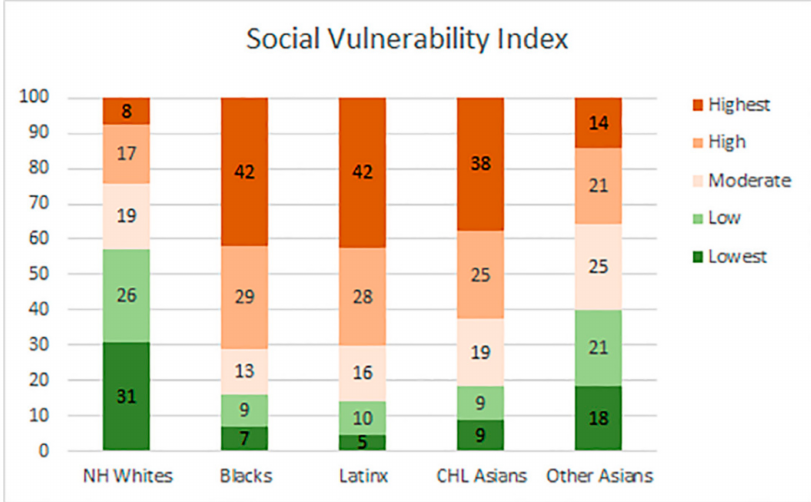
Figure 9. Ethnoracial distribution by neighborhood social vulnerability